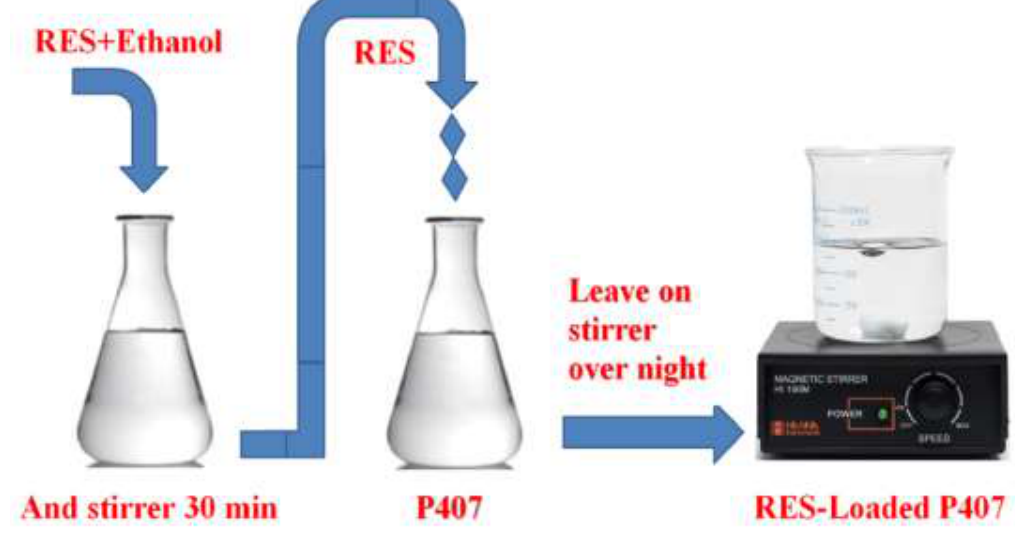
Figure 2: Preparation of RES-loaded poloxamer 407 nanoparticles. P407: poloxamer407, RES: